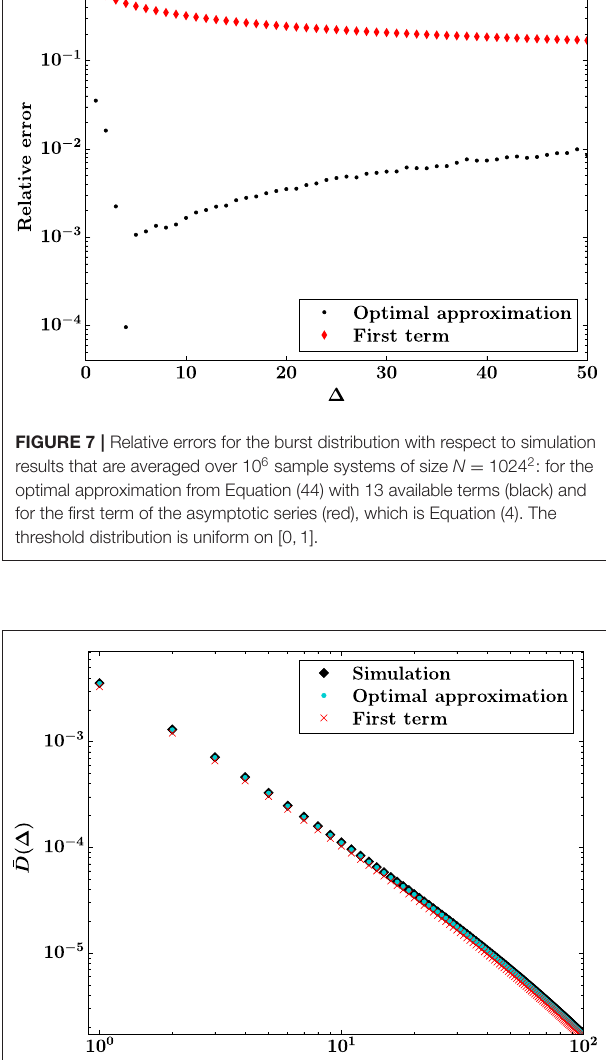
FIGURE 6 | Optimal approximation from Equation (44) with 13 available terms (turquoise) and simulation results (black, N 1024 2 , 10 6 samples) for the burst distribution. The first term of the asymptotic series (red), which is Equation (4), is shown for comparison. The threshold distribution is uniform on [0,1].